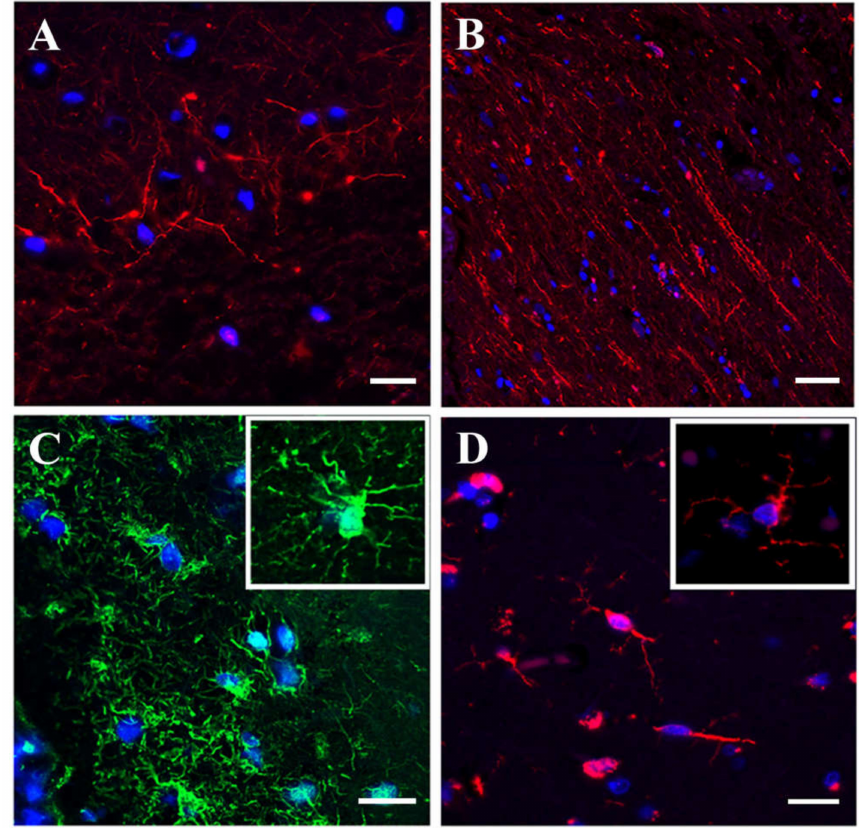
Figure 3. Immunofluorescence analysis of human stroke brain tissue IF staining of human stroke brain tissue collected at 48 h after stroke onset. A, B: Pan-neuronal antibody staining (red) visualizing small unipolar and bipolar ( A ) and spindle-shaped ( B ) neurons. ( C ): GFAP (green) immunostaining for astrocytes. ( D ): Iba-1 (red) immunostaining for microglia. Bars: ( A , C , D ): 20 µ m, and ( B ): 50 µ